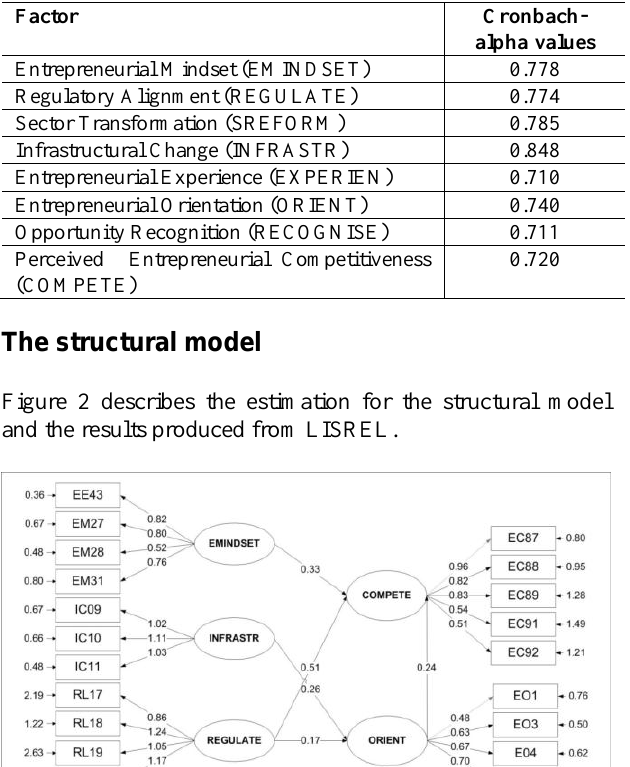
Table 4: Internal reliability assessment